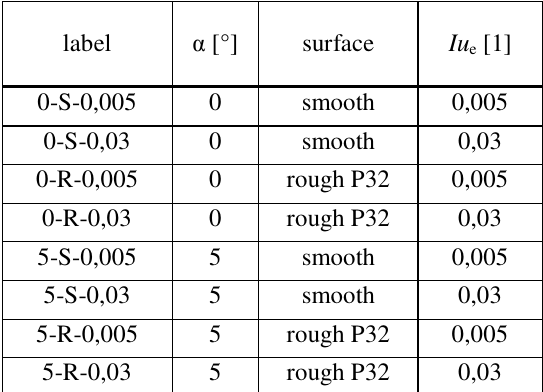
Table 1. List of the test cases. Combination of the external conditions of the development of the boundary layer along flat